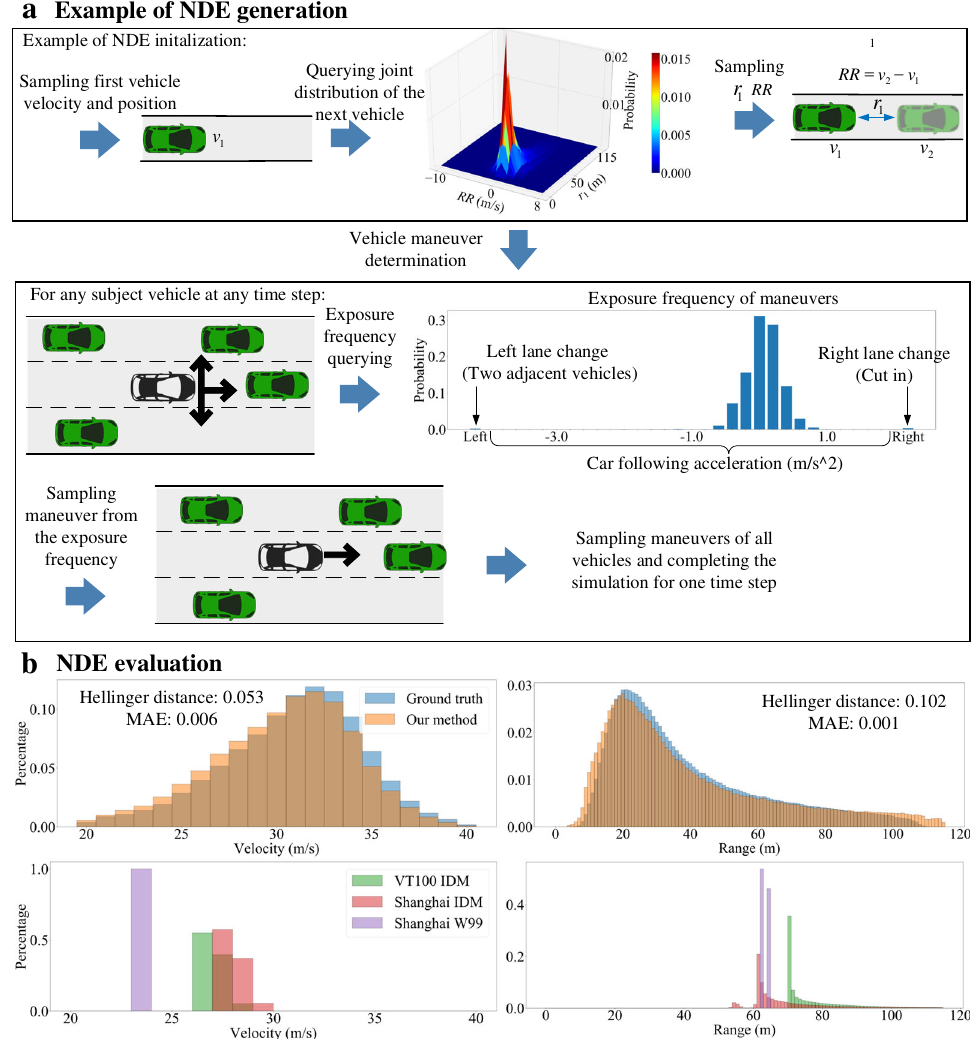
Fig. 3 Generation and evaluation of the NDE. a Example of the naturalistic driving environment (NDE) generation including initialization (top) and vehicle maneuver determination (bottom). The image of vehicles is previously published at https://commons.wikimedia.org/wiki/File:C3top.png under the Creative Common CC0 1.0 Universal Public Domain Dedication b Evaluation results of the generated NDE. Top: the ground truth comes from the distributions of naturalistic driving data, and the distributions of our method come from simulations of the generated NDE. Bottom: simulation results of the intelligent driving model (IDM) model calibrated by the dataset from Virginia and Shanghai, respectively, and the Wiedemann99 model calibrated by the dataset from